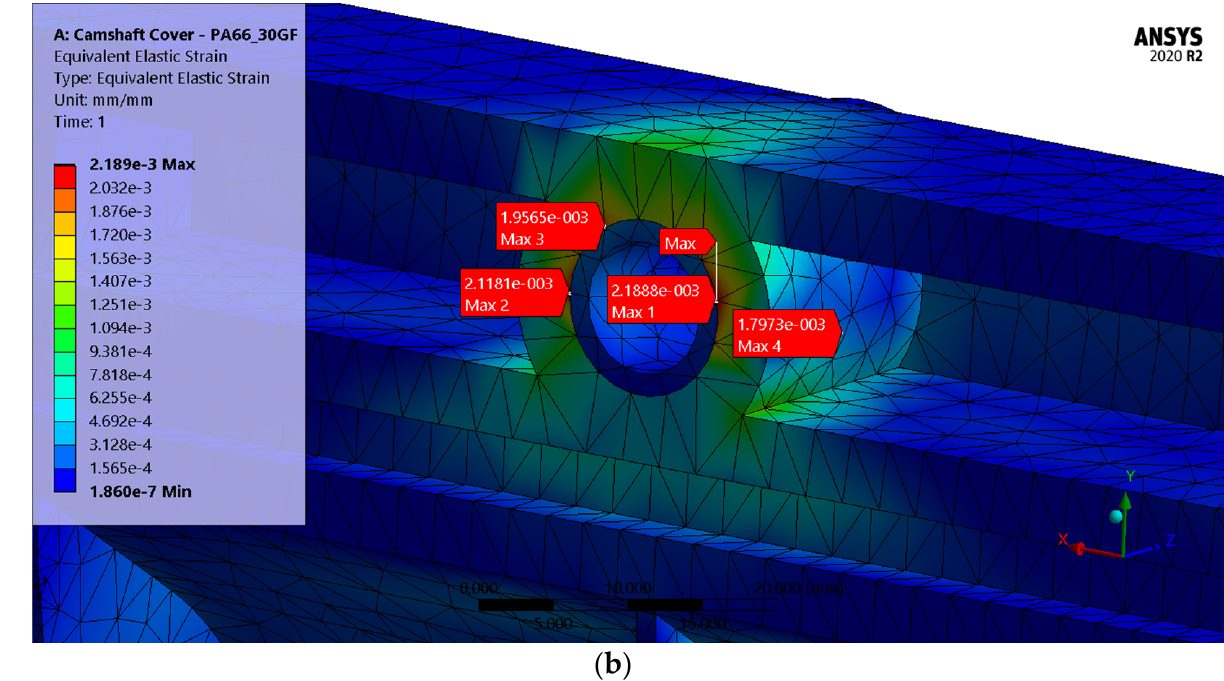
Figure 7. FEA results: ( a ) Equivalent (von-Mises) stress; ( b ) Equivalent elastic strain. A further quantity that was calculated during the FE analysis consists of the maximum vertical displacement in correspondence with the gasket housing (Figure 8). Through this result, the compression value C actually exerted by the gasket when the cover is deformed under the action of the acting pressures was calculated by means of the following equation: (cid:16) (cid:17) d gasket − h housing + vd C [ % ] = 100 (1) d gasket in which d gasket represents the gasket diameter and is equal to 5 mm; h housing represents the height of the gasket housing and is equal to 3.5 mm; vd represents the vertical dis- placement in correspondence with the gasket housing evaluated from the FE analysis. The recommended compression value on the gasket for static applications is between 15 and 30%, with 30% the initial value when the vertical displacement of the gasket housing is null and 15% the minimum value able to guarantee the correct sealing of the gasket. On the basis of the results obtained, the compression value C for the plastic cover is equal to 28.8% and therefore is within the optimal range of